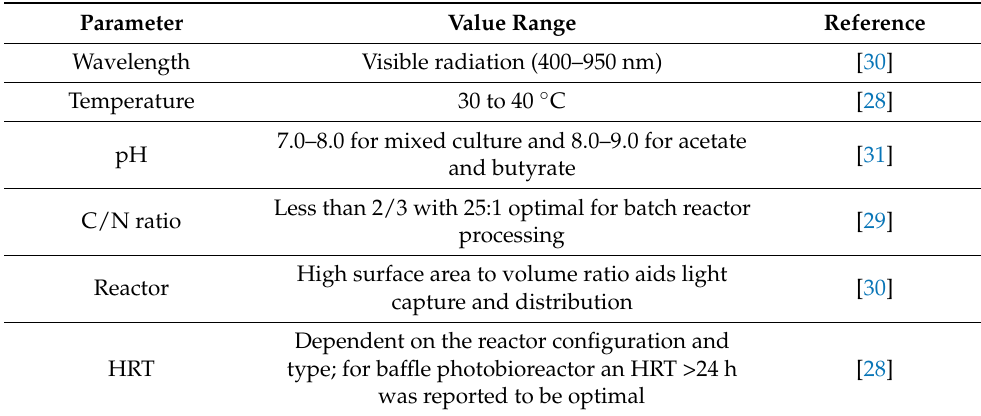
Table 3. Key parameters and optimal range influencing the H 2 production in